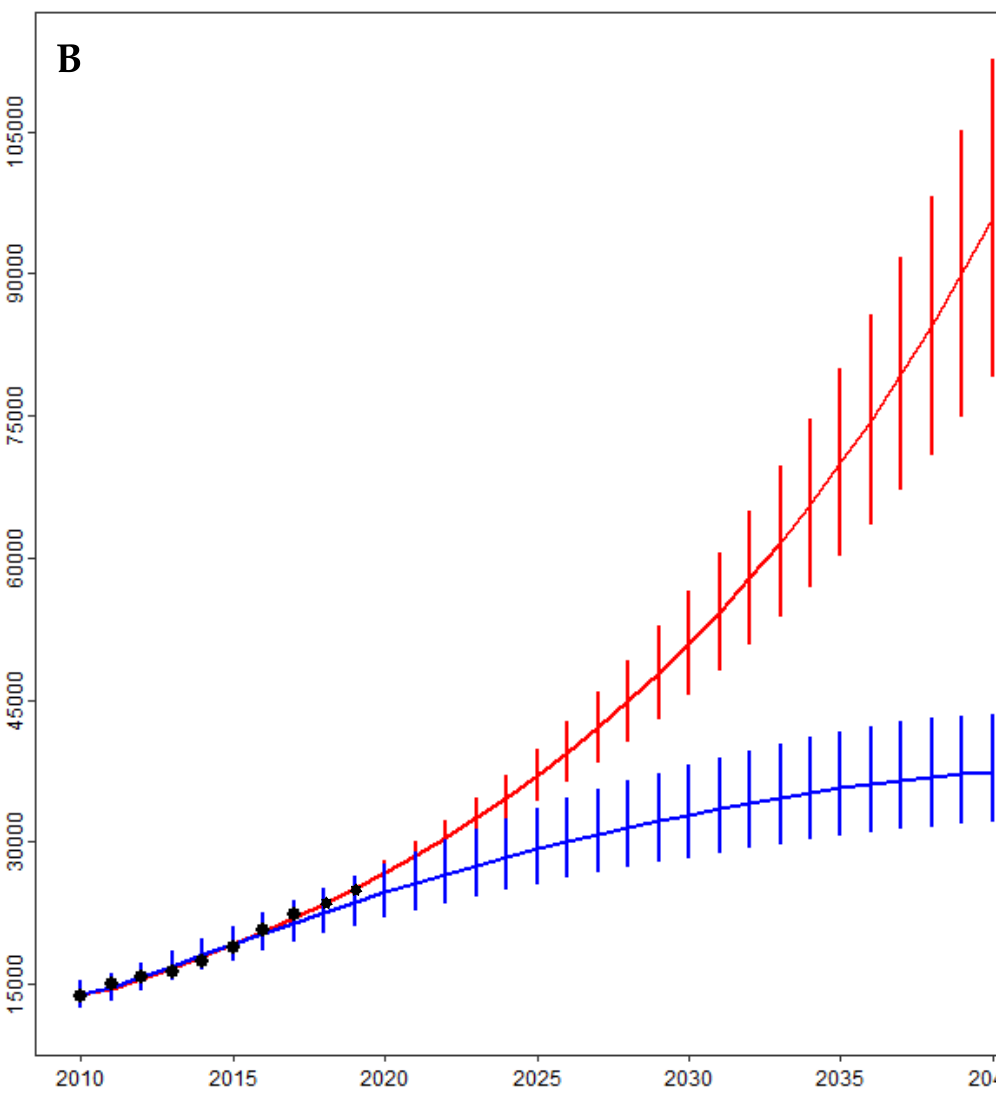
Figure 3. Projections of the incidence ( A ) and total number ( B ) of shoulder arthroplasties by the year 2040 based on a Poisson (red) and a negative binomial regression model using a monotone B-spline approach (blue). The black points represent the historical numbers.